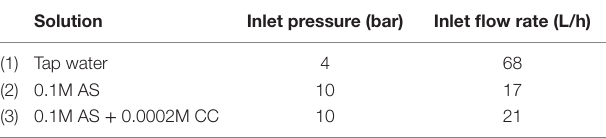
TaBle 3 | The performed experiments with an rO membrane (1–3).